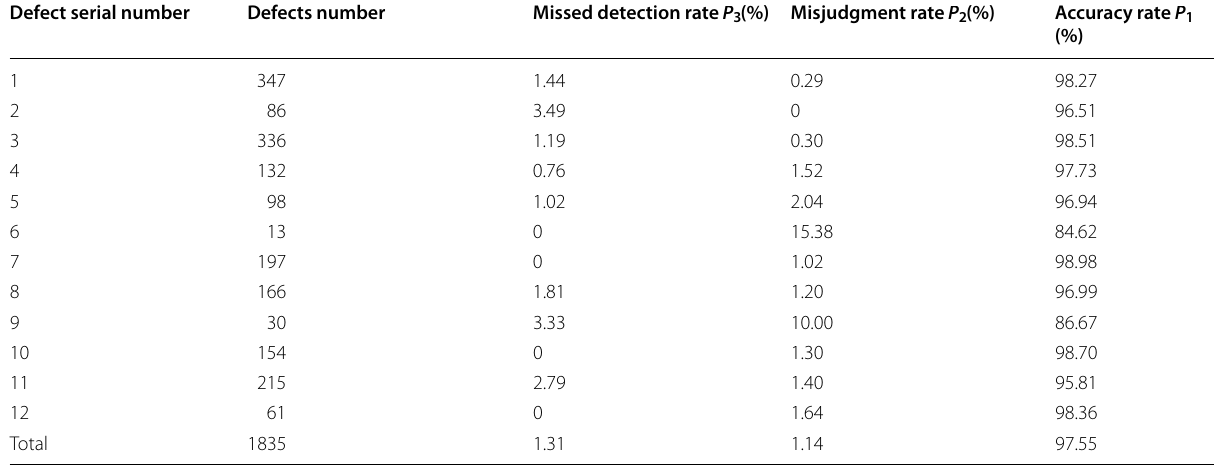
Table 3 On-site ultrasound image test results for railway track Defect serial number